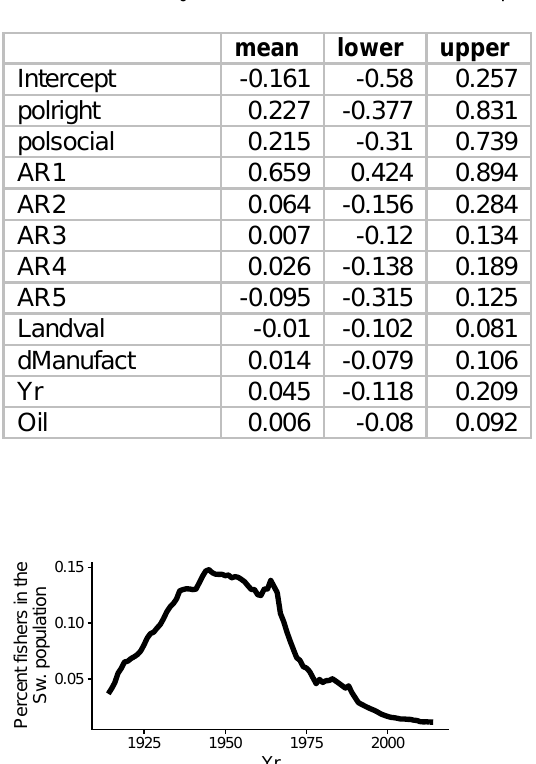
Table A1.7 . Average weighted parameter values for statistical models (mean and 95 % confidence intervals) for models for subsidy color (fraction beneficial to capacity enhancing subsidies) for 1914-1994.